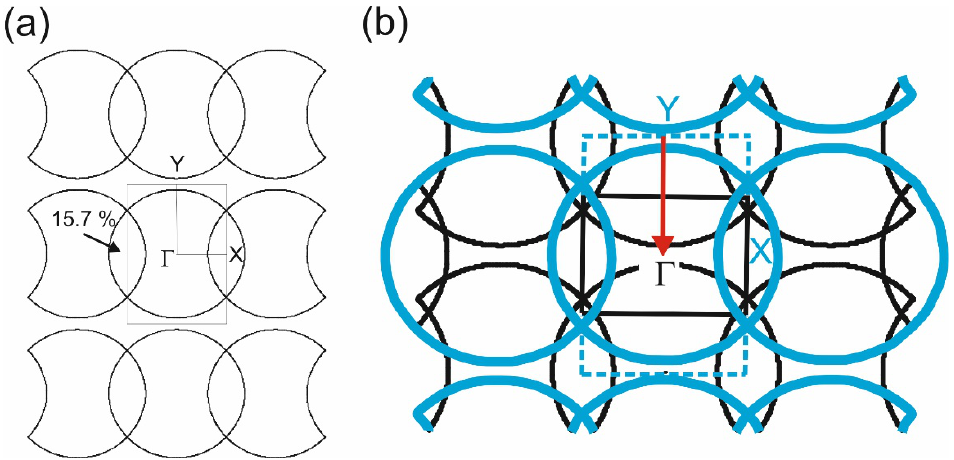
Figure 6. ( a ) Calculated Fermi surface for the donor lattice of the high-temperature crystal structure of κ -(BEDT-TTF) 2 Hg(SCN) 2 Br, where Γ = (0, 0), X = ( c */2, 0), Y = (0, b */2, 0), M = ( c */2, b */2), and S = ( − c */2, b */2). Note that the a - and c -directions are interchanged with respect to those in the low- temperature structure. We keep the same labelling for the high- and low-temperature structures in order to facilitate the comparison of the two FSs. ( b ) Construction of the Fermi surface of the low- temperature donor layer from that of the high-temperature one using a folding process along the b *-direction (see text).